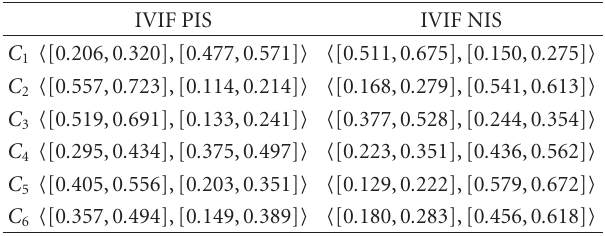
Table 14: Atanassov’s interval-valued intuitionistic fuzzy PIS and NIS.